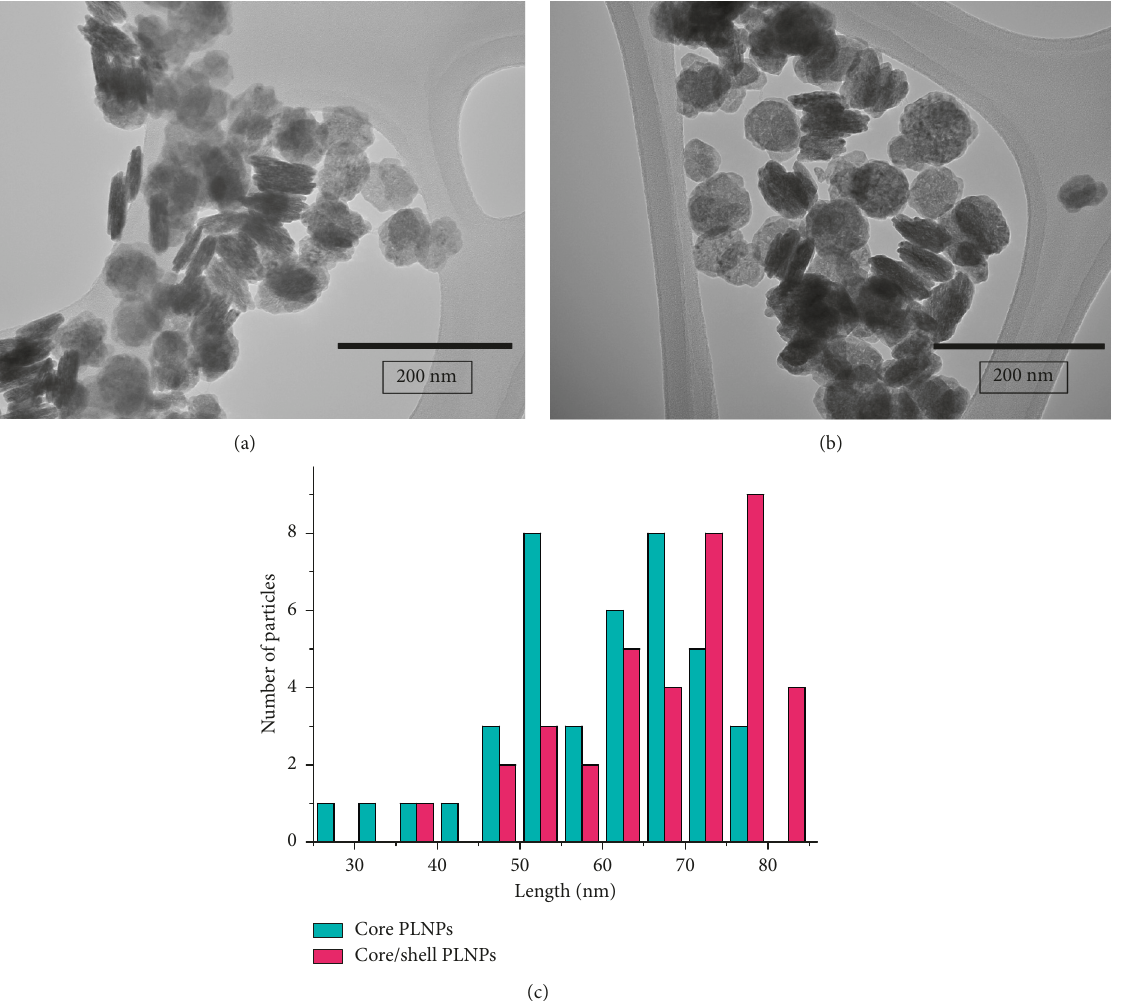
Figure 1: TEM image of (a) core nanoplates and (b) core/shell nanoplates. (c) The size distribution of core nanoplates and core/shell